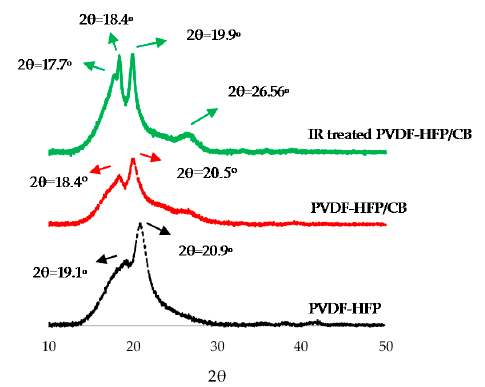
Figure 7. XRD of PVDF-HFP (in black), PVDF-HFP/CB (in red) and IR treated PVDF-HFP/CB (in green) (2 θ between 10° to 50°).